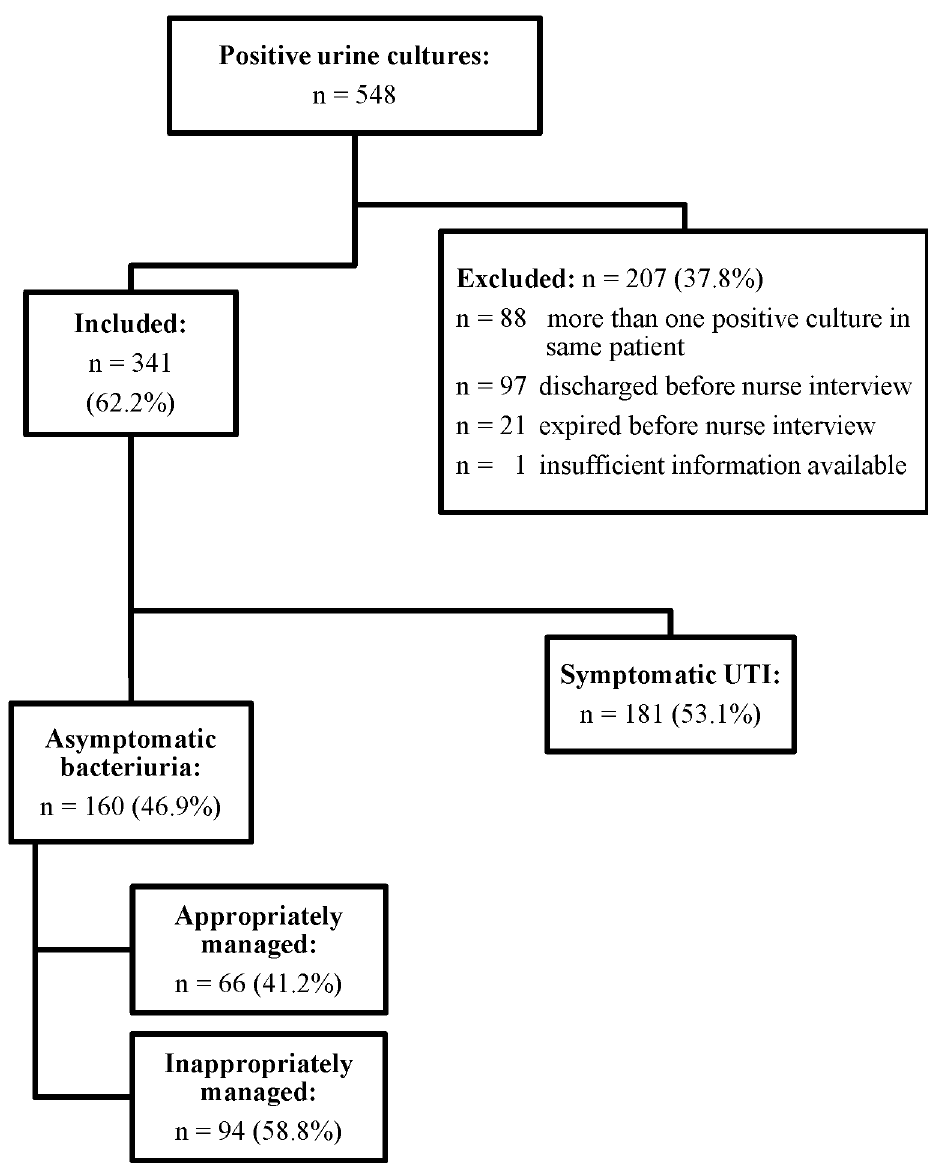
Fig 1. Flow chart baseline phase January 30 to April 17